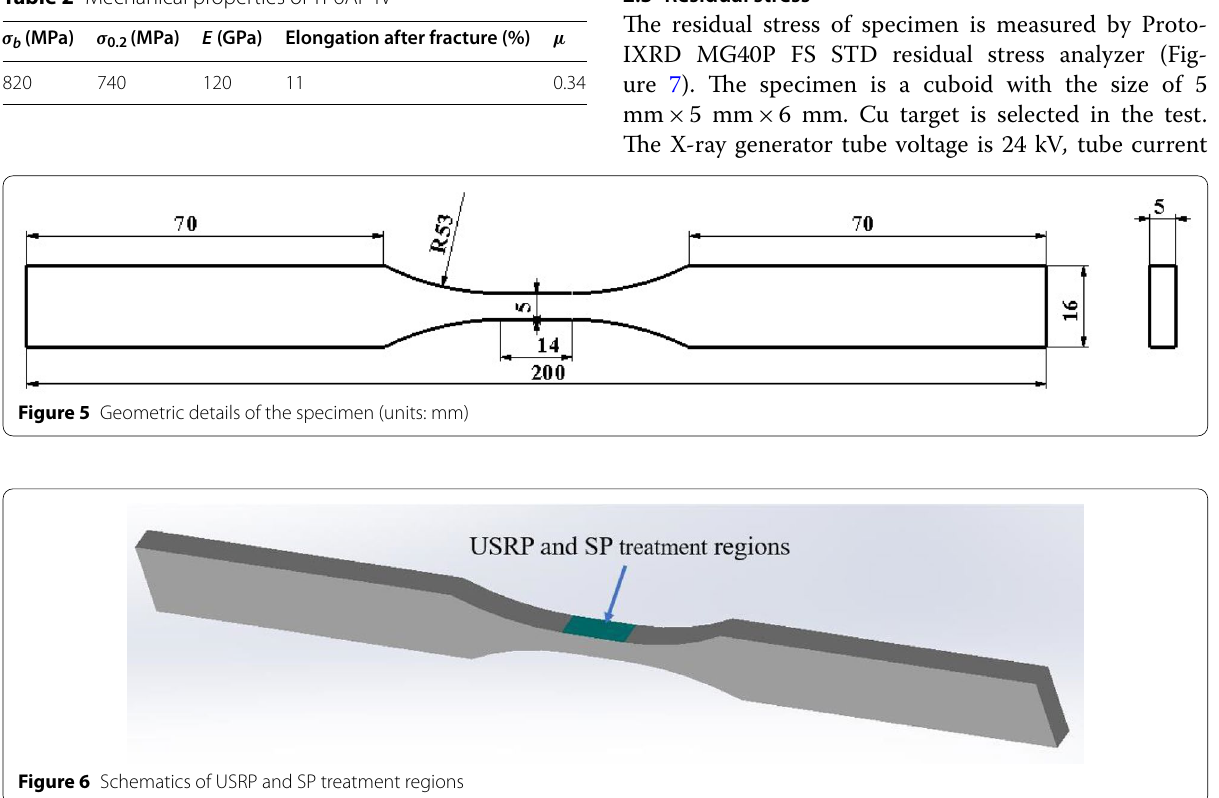
Table 2 Mechanical properties of Ti-6Al-4V